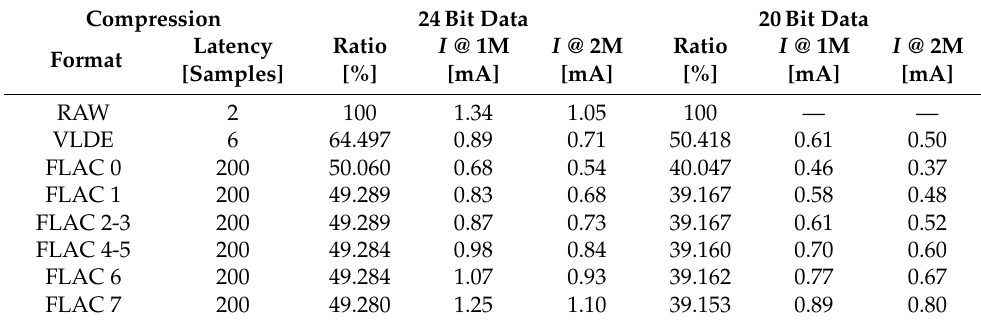
Table 4. Data compression ratio and processing/transmitting sensor current consumption for differ- ent compression formats and different BLE PHY speeds. The baseline current consumption for the analog parts and clocking is 2.07mA and 2.06mA for the 1M and 2M PHYs,